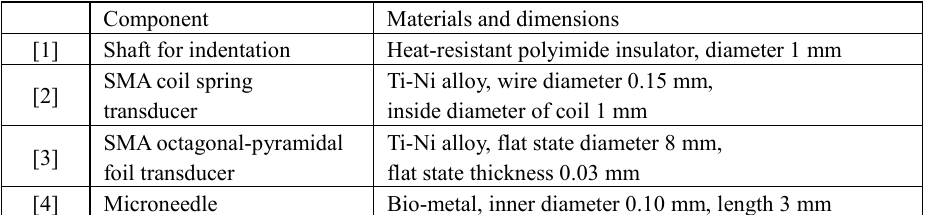
Figure 1. Cartridge type minimally invasive SMA double-transducer unit for either blood suction or drug injection. Table 1. Main components of SMA double-transducer unit.